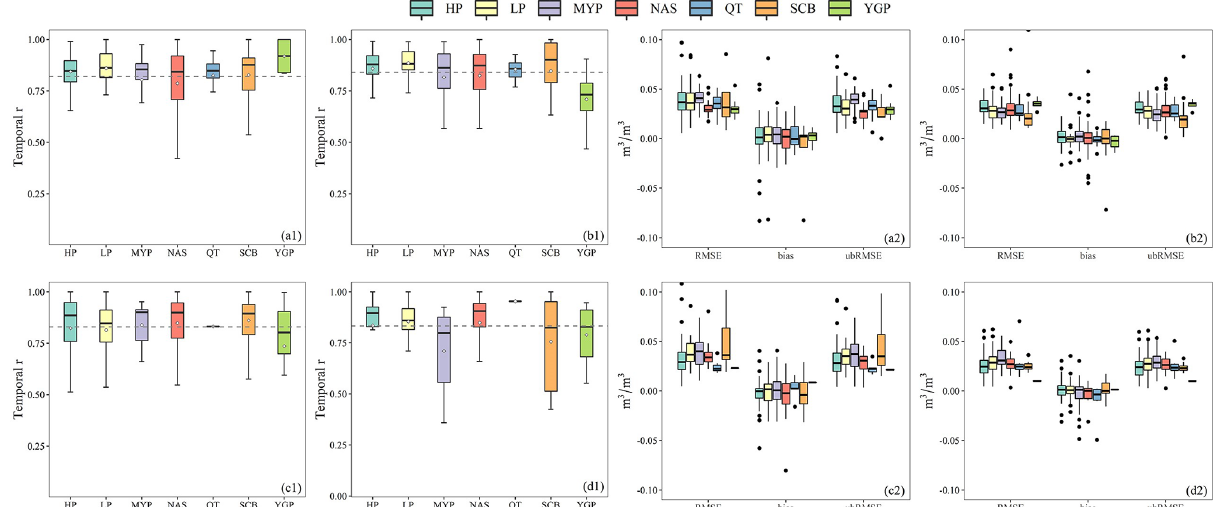
Figure 7. Comparison of the temporal accuracy ( r , RMSE, bias, ubRMSE) between ChinaCropSM1 km and in situ soil moisture observations by crops and depths. (a1, a2) wheat 0–10 , (b1, b2) wheat 10–20 , (c1, c2) maize 0–10 and (d1, d2) maize 10–20 . The dashed lines represent the mean